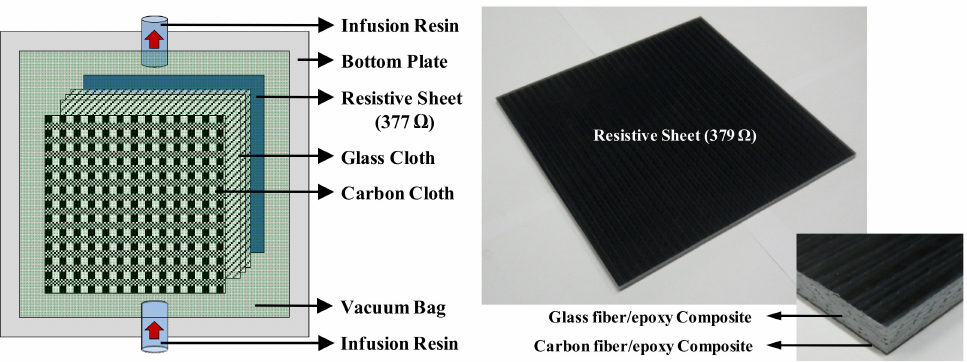
Figure 13. Fabrication of the Salisbury screen